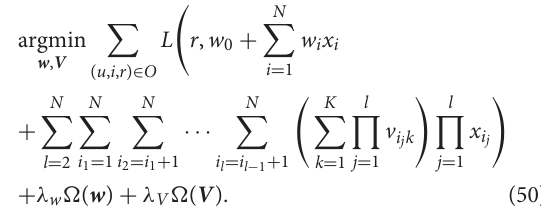
NCF ( Figure 17 ) consists of two parts: generalized matrix factorization (GMF) and multi-layer perceptron (MLP). The GMF layer computes the element-wise product of user and item latent factors. The MLP layer is a neural network that takes the concatenation of user and item latent factors as inputs and outputs a vector. The results of GMF and MLP are then concatenated as a vector and serve as the input of the NeuMF layer, which is a one-layer perceptron and outputs the predicted rating. Normally, a user/item attribute is a one- hot encoding vector that represents the user/item. However,